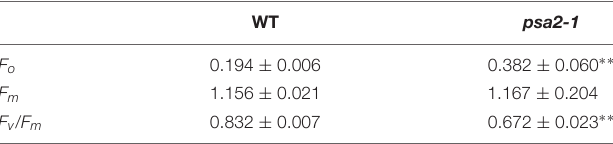
TABLE 2 | Chlorophyll fluorescence parameters in the leaves of the wild-type (WT) and psa2-1 plants grown under growth light (100 µ mol photons m − 2 s– 1 ).